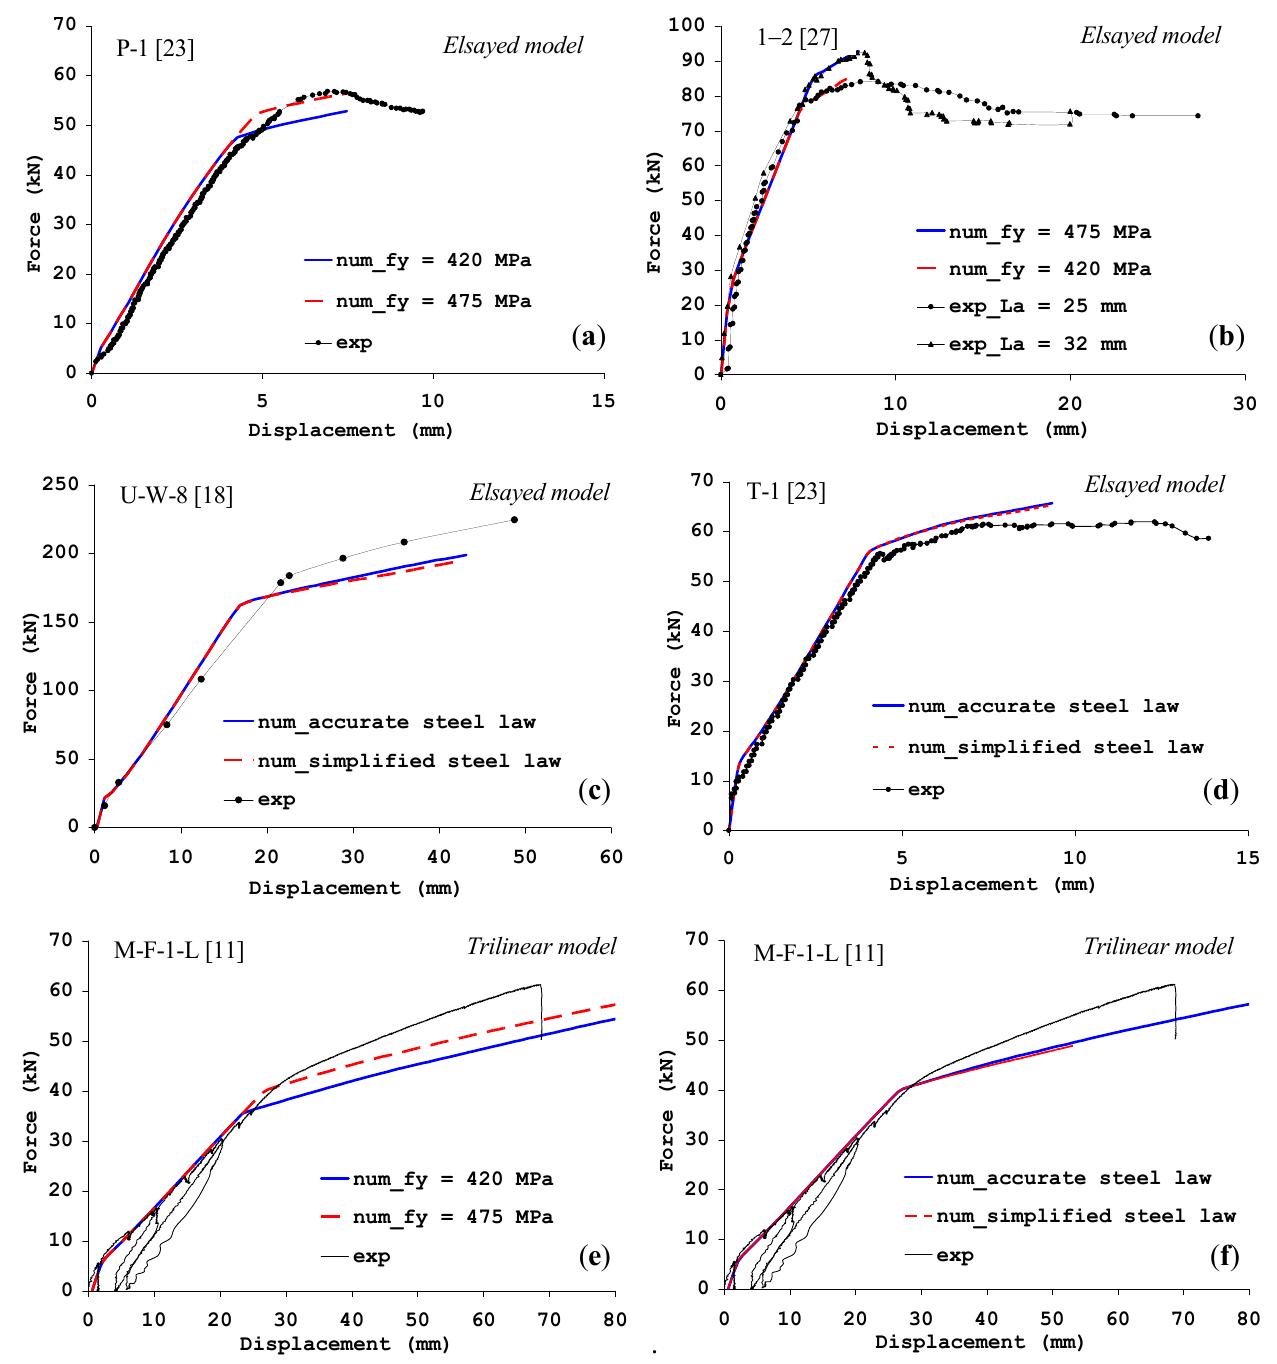
Figure 8. Influence of the mechanical properties ( a , b , e ) and stress-strain law ( c , d , f ) of steel